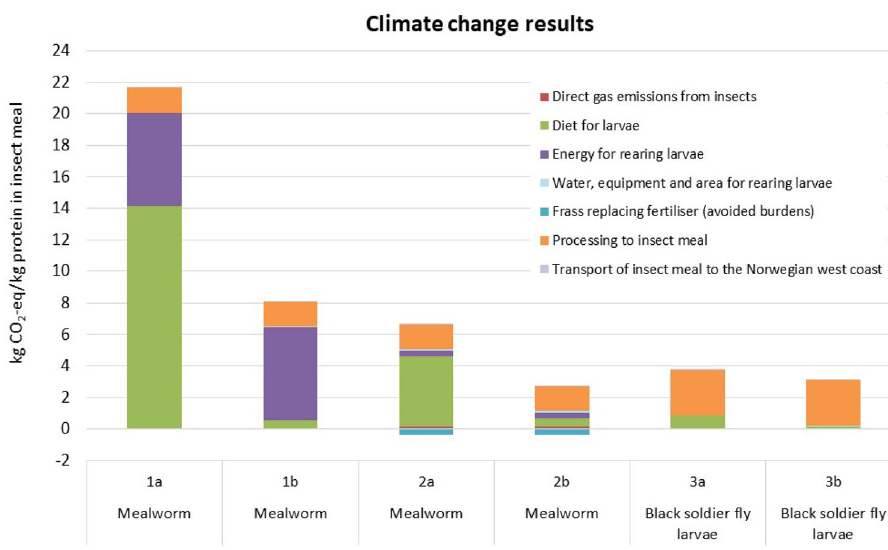
Fig. 4 Climate change results for rearing and processing insects into insect meal (per kg protein delivered to the west coast of